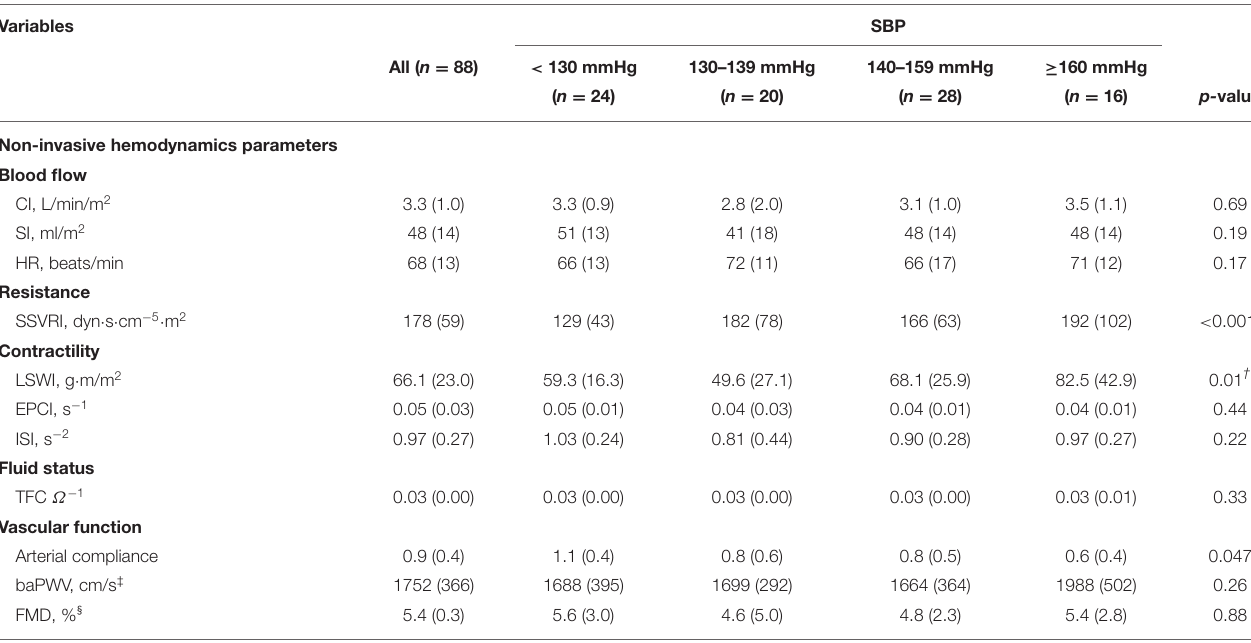
TABLE 2 | Comparisons of ICG parameters and vascular function among blood pressure